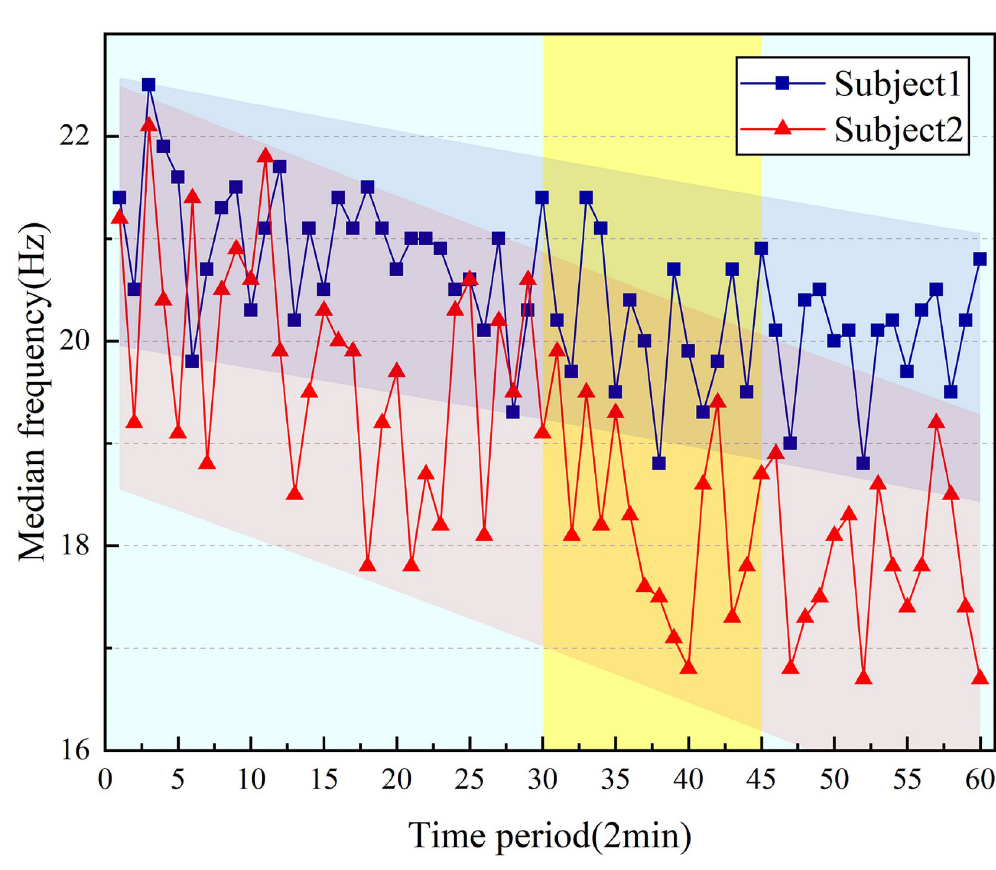
Fig 10. Change of sEMG median frequency.